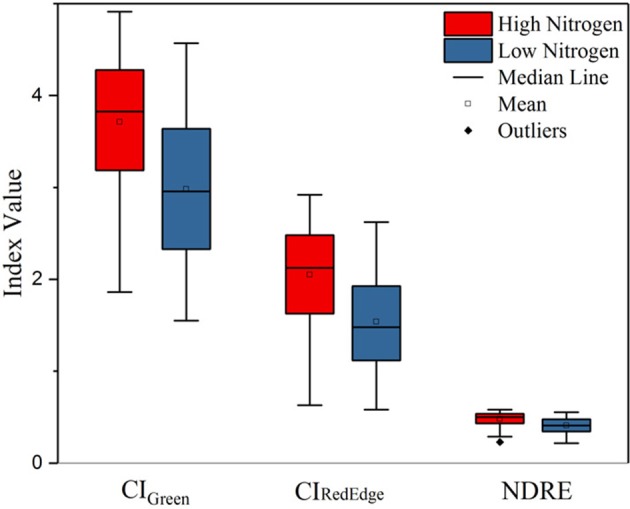
Boxplot of three VIs (CIGreen, CIRedEdge, and NDRE) derived from the late season multispectral images of the low and high nitrogen treatments.